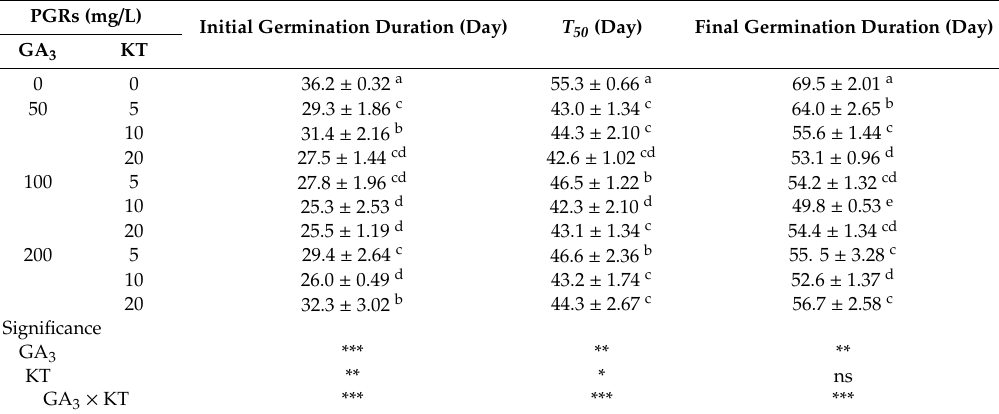
Table 3. E ff ect of the combination of GA 3 and KT on the seed germination of Tulipa thianschanica